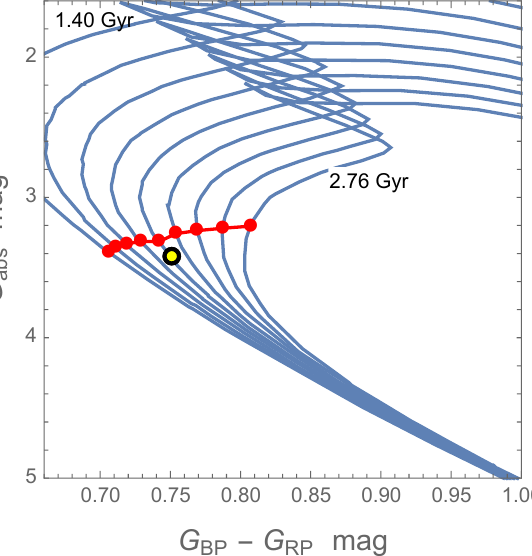
Figure 1. Isochrones from the PARSEC suite of stellar models for 9 equally spaced stellar ages as labeled in the plot computed for the Gaia EDR3 photometric system. The observed location of WASP-12 is shown with a filled circle. The red line with dots shows the evolutionary track of the closest nodal initial mass 1.4 M after the turn-off ☼